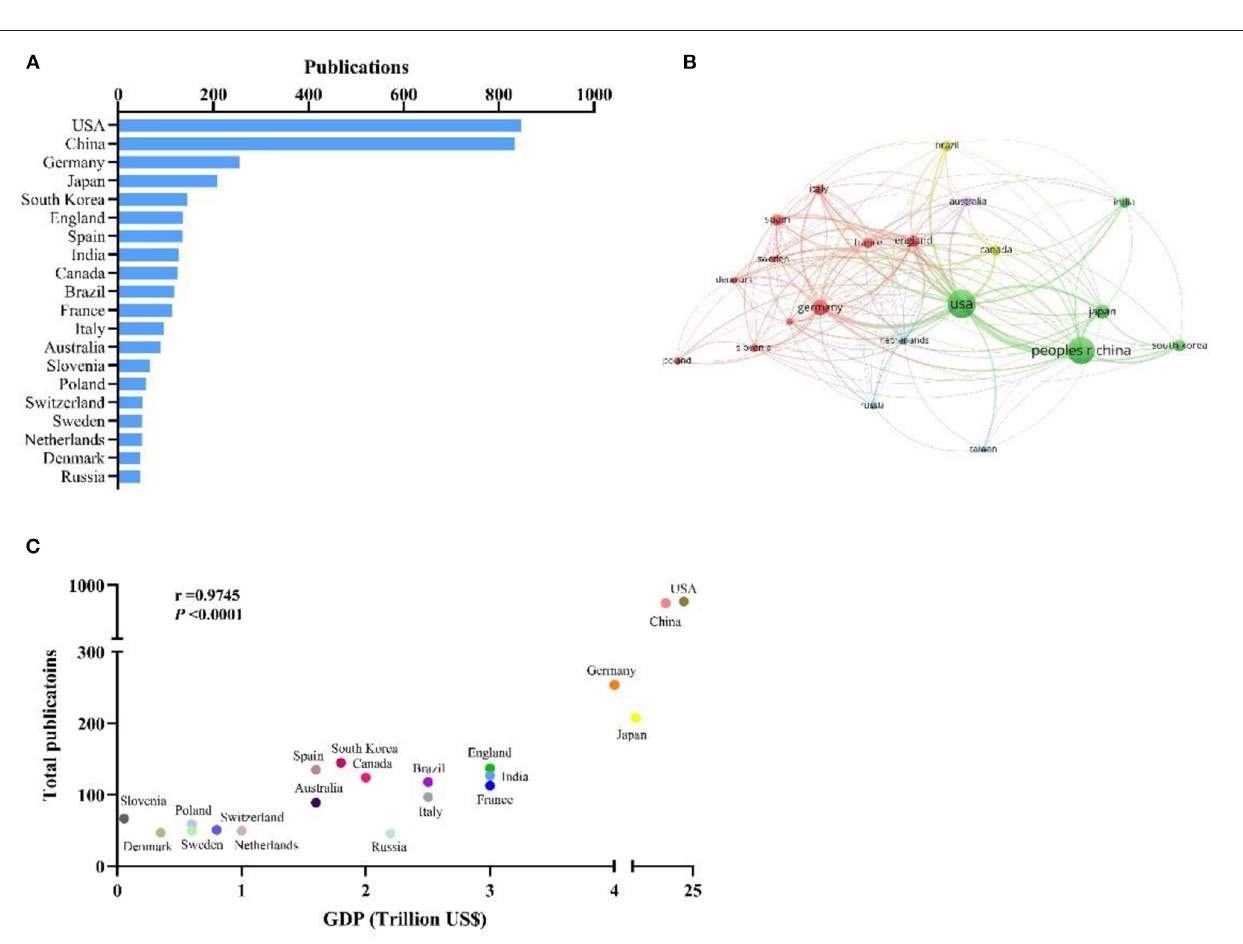
Figure 2A . USA and China accounted for the highest number of papers ( n = 847 and 833, respectively), followed by Germany ( n = 254), Japan ( n = 208), South Korea ( n = 145), England